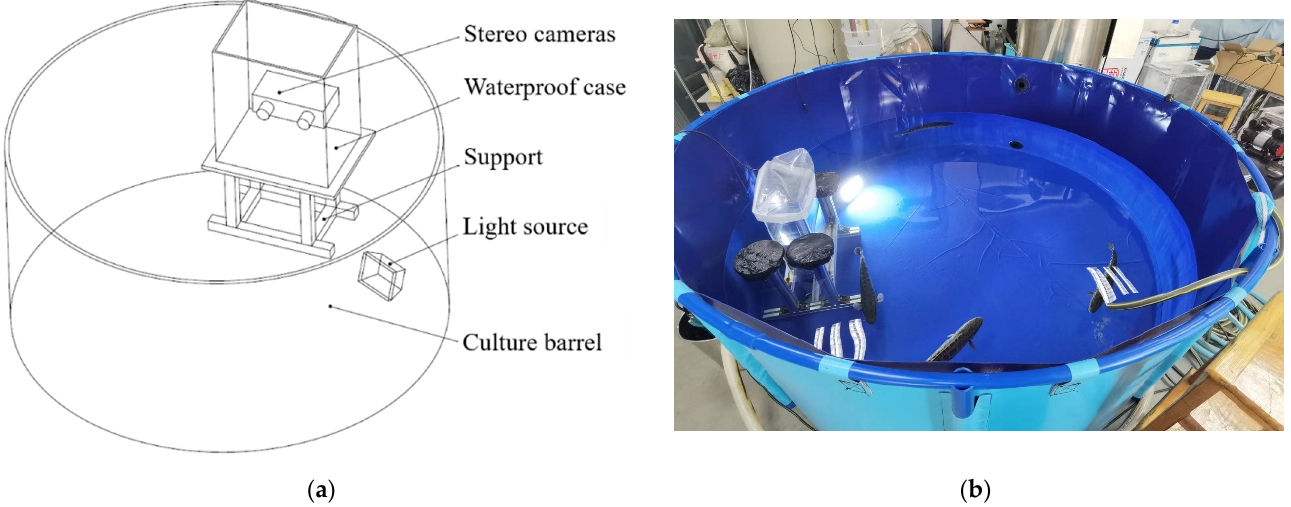
Figure 1. Schematic diagram of the image acquisition platform, ( a ) Structure of the platform, ( b ) Photo of the actual device. ( b ) Photo of the actual